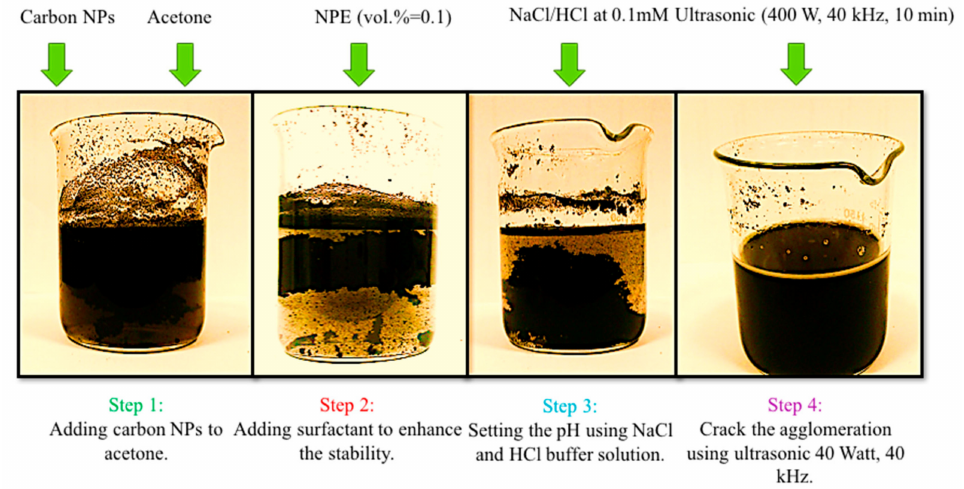
Figure 1. Preparation and dispersion of the carbon nanoparticles in acetone in four steps.